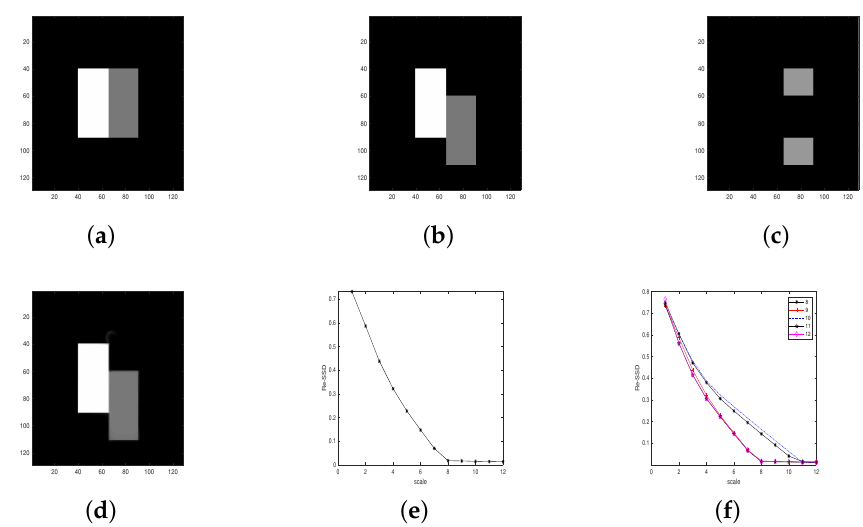
Figure 1. Registration result of Algorithm 2 on image pairs Rectangle. ( a ) T ( · ) . ( b ) D ( · ) . ( c ) | T − D | . ( · ) . ( e ) Re − SSD change (Rectangle) with scale number. ( f ) Θ n / Re − SSD / scale . ( d ) T ◦ ˆ h K M